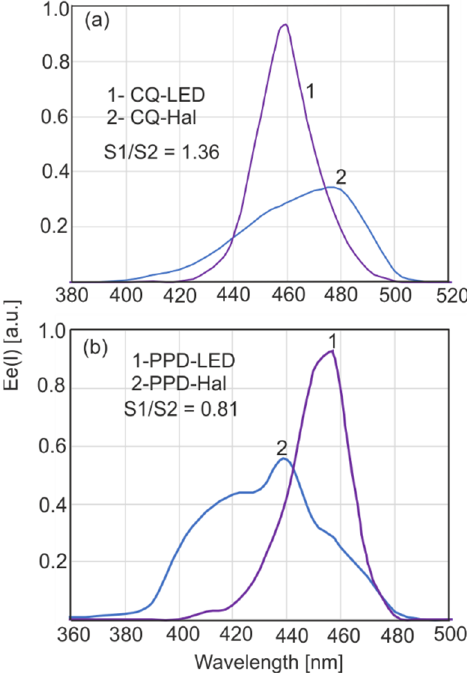
Figure 5. Relative, effective absorption coefficients for CQ ( a ) and PPD ( b ).